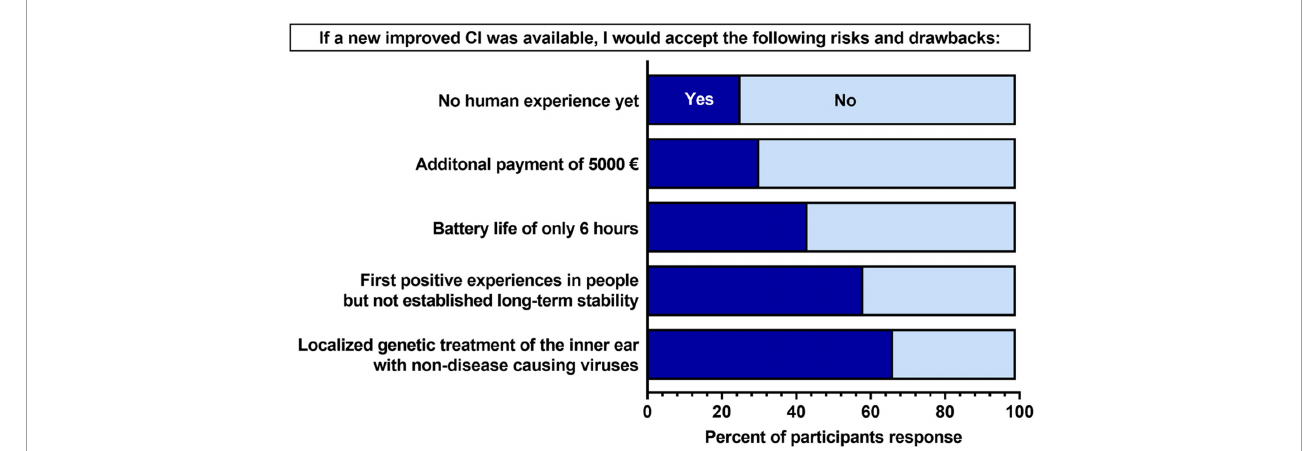
FIGURE2 Participants’ acceptance of hypothetical risks and drawback associated with a new cochlear implant (CI). Percent values are out of the total number of participants who completed each question ( N = 76–81). Participants were asked “If you were to be hypothetically implanted with a new CI that was expected to improve the limitations mentioned in Section I of the questionnaire ( Supplementary material 2 ), which of the following risks and disadvantages would you accept in this new CI?” Dark blue indicates an response of “yes,” and light blue indicated a response of “no.”